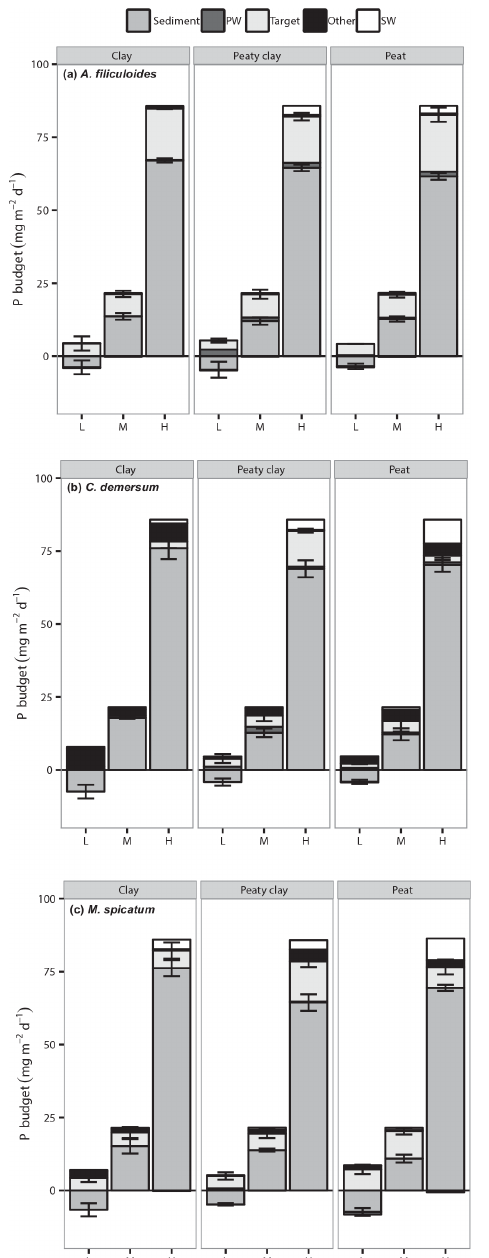
Figure 4. P budgets of sediment, surface water, pore wa- ter, target species and other plants subjected to different nutri- ent loadings (L: 0.43mgPm − 2 d − 1 ; M: 21.4mgPm − 2 d − 1 ; H: 85.7mgPm − 2 d − 1 ) for (a) A. filiculoides , (b) C. demersum , and (c) M. spicatum . Standard errors are given only for sediment and target species. PW: pore water; SW: surface water. Positive values represent P accumulation in relative parts; negative values represent P release from respective compartments.